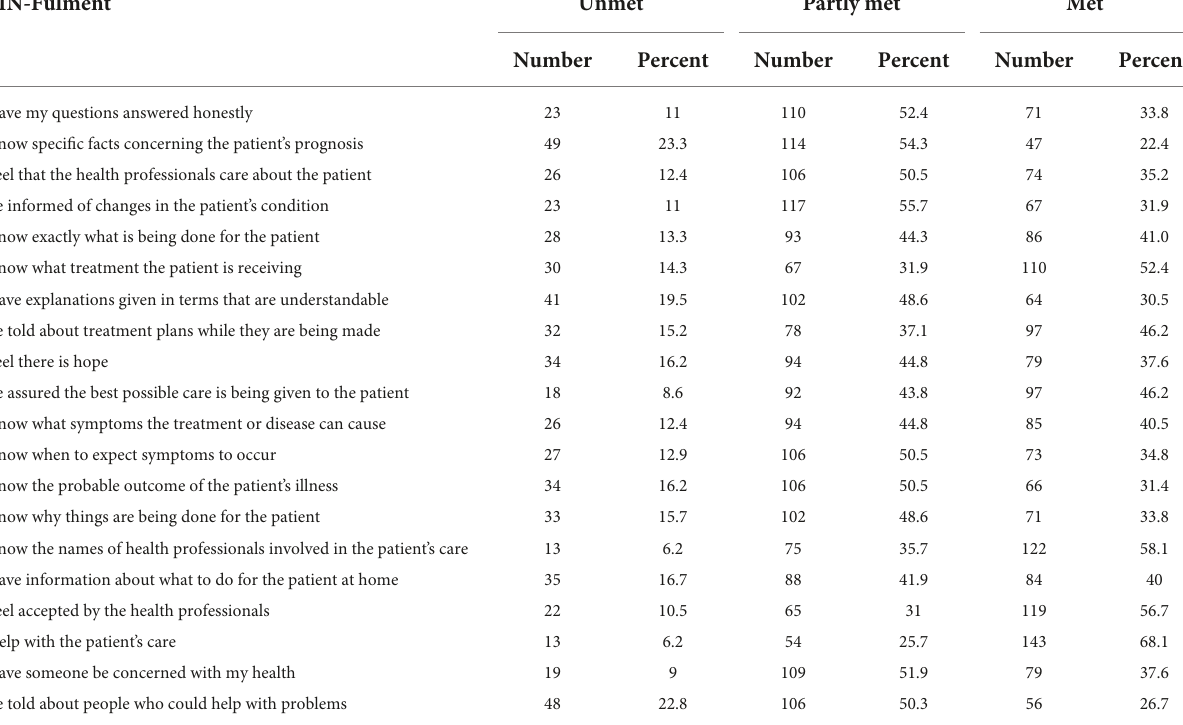
TABLE 3 Unmet needs of mothers with children with cancer.